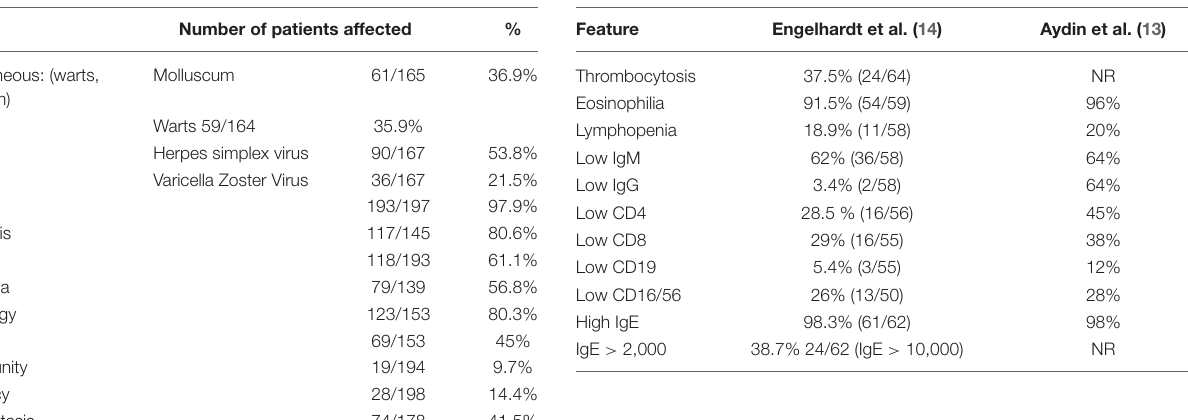
TABLE 1 | Clinical features reported in 200 patients with DOCK8 deficiency. TABLE 2 | Laboratory features found in 200 patients with DOCK8